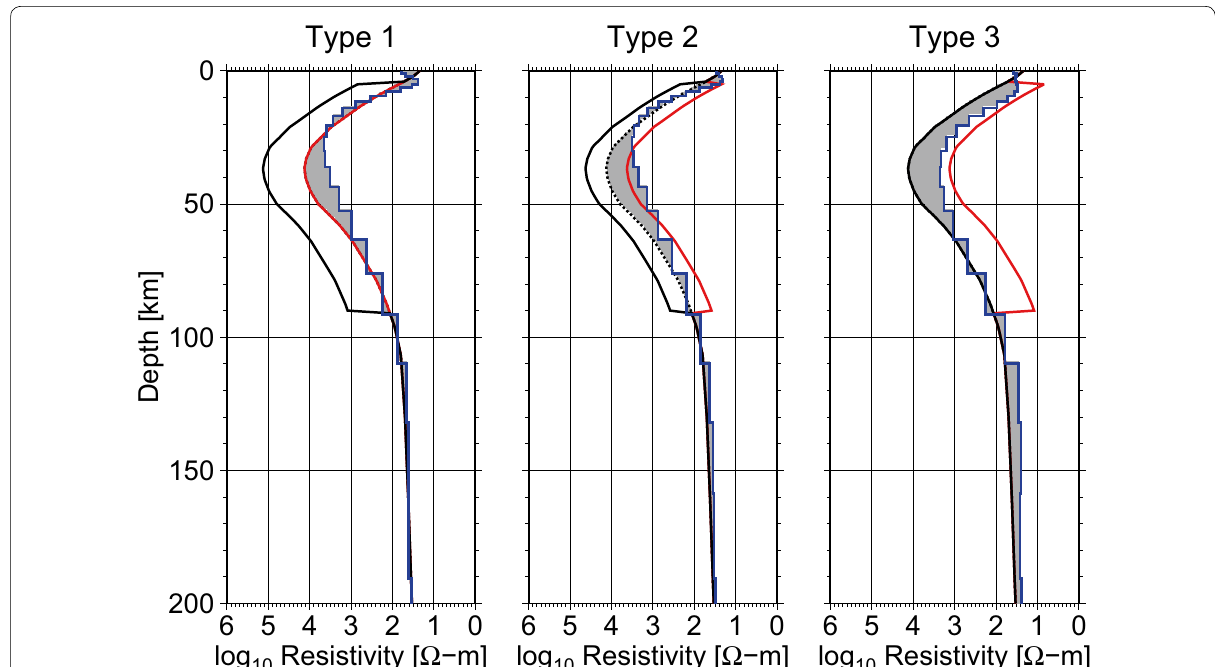
Fig. 4 2D isotropic inversion results (blue lines) of 1D anisotropic data produced from three types of synthetic true models. Discrepancy between the 2D isotropic inversion model and the true 1D isotropic model is shaded in each plot. The synthetic true models are same as Fig.